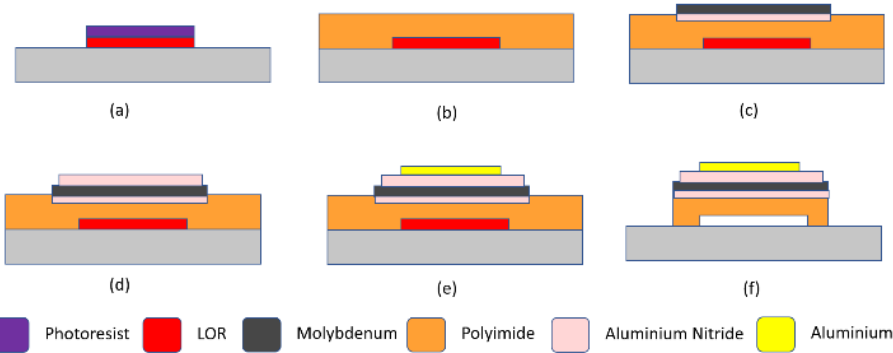
Figure 3. Fabrication protocol of the FBAR on the flexible membrane using an organic LOR sacrificial layer. ( a ) Patterning of the sacrificial layer, ( b ) covering with the protection layer, ( c ) patterning of the bottom electrode, ( d ) patterning of the piezoelectric layer, ( e ) patterning of the top-electrode, and ( f ) etching of the protection layer and releasing of the structure.